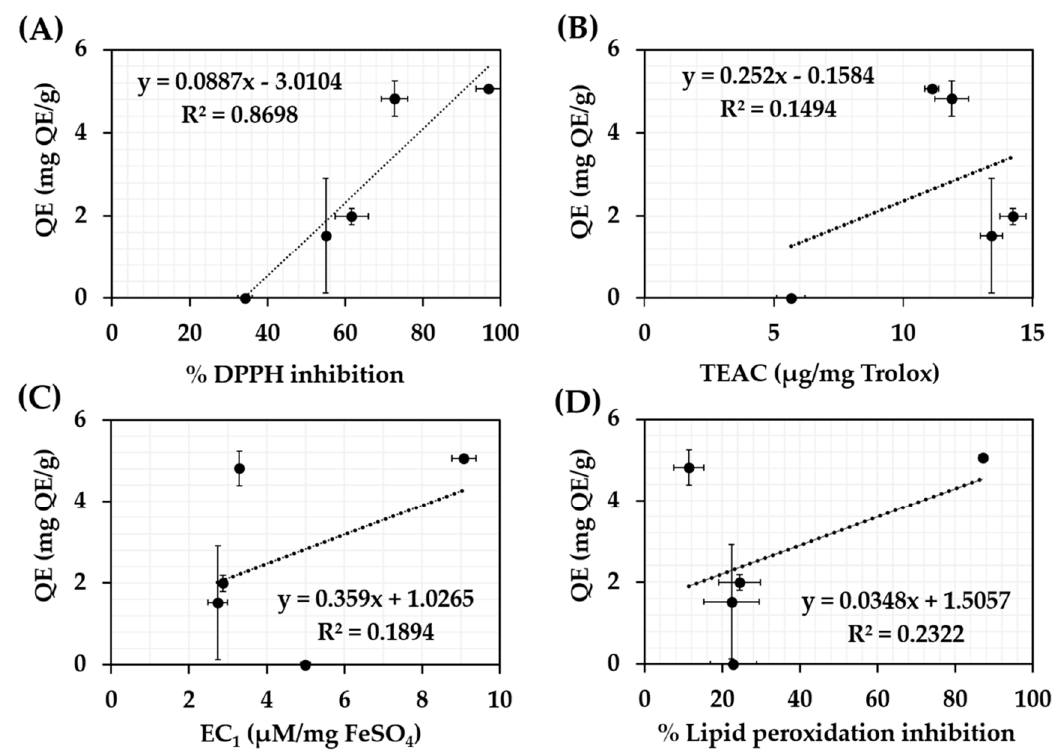
Figure 3. Correlations between total flavonoids content and antioxidant activities of C. militaris